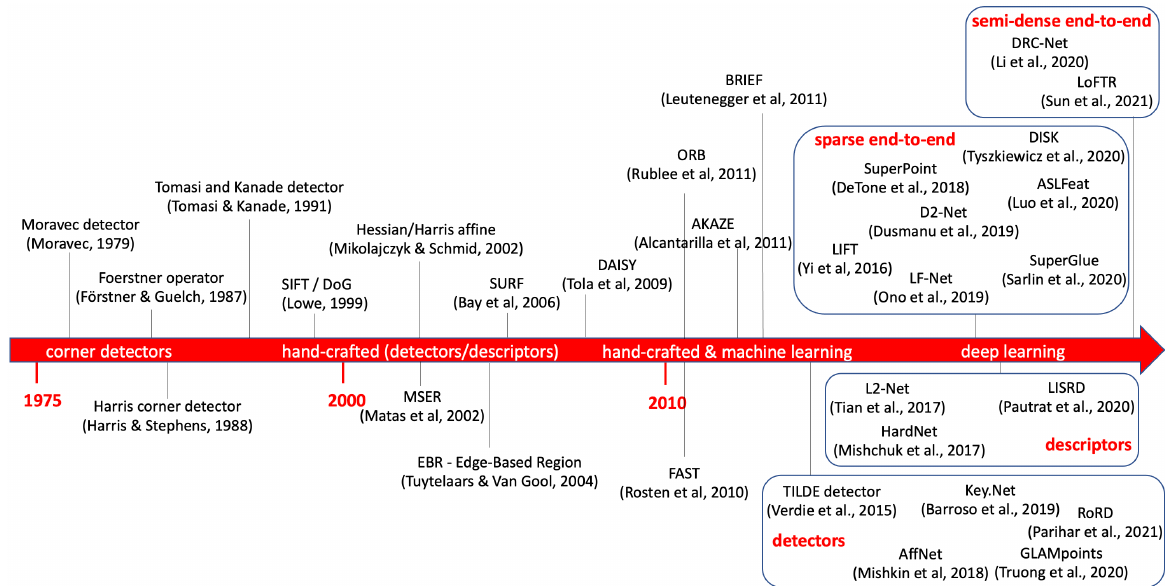
Figure 1: Some milestone methods within the evolution of image matching for tie point